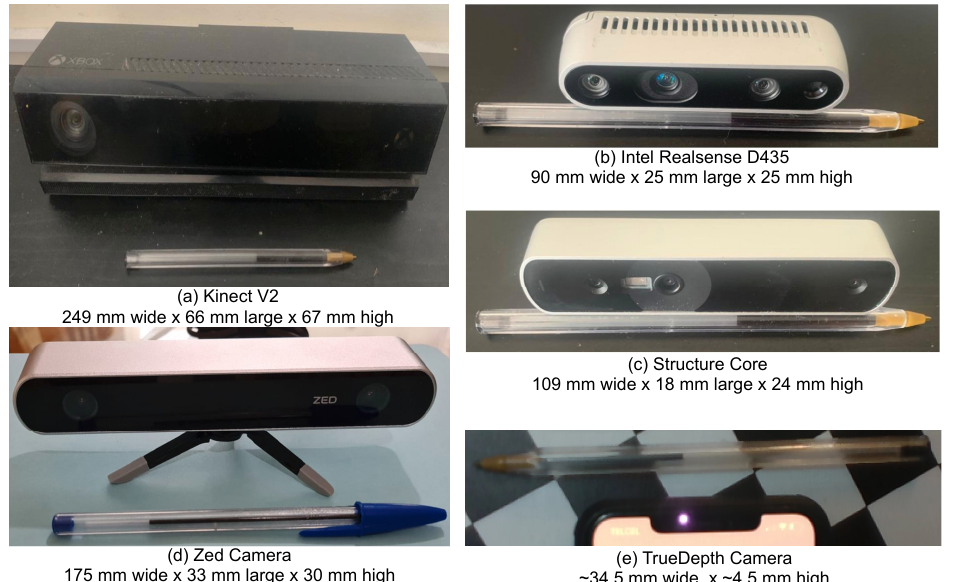
Figure 1. RBB-D cameras, ( a ) Kinect, ( b ) Realsense D435, ( c ) StructureCore, ( d ) Zed Camera, ( e ) TrueDepth Camera.